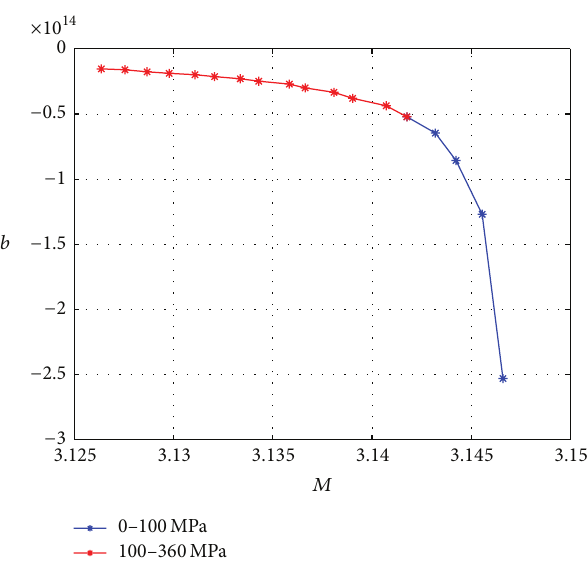
Figure 2: The fitting curve 𝑀 - 𝑏 of an A2-70 austenitic stainless steel